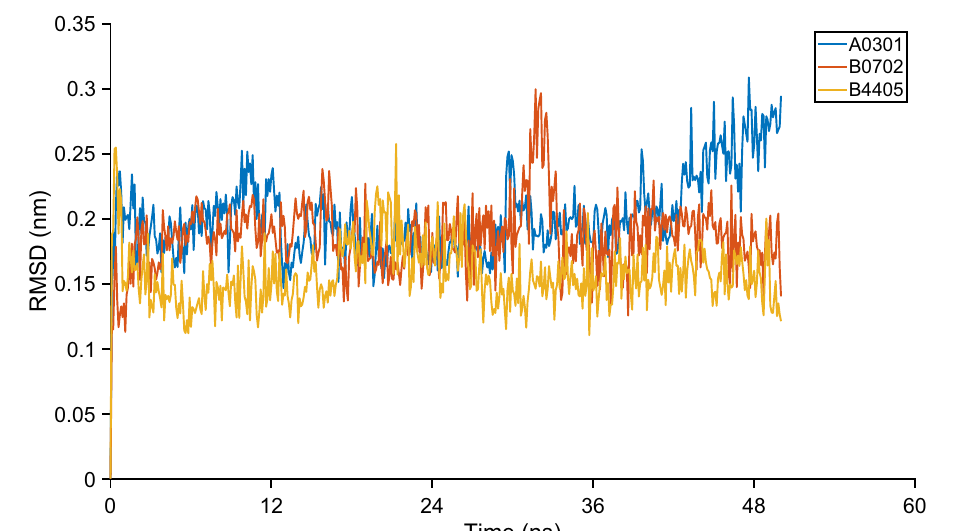
Figure 6. The RMSD plot of the HLA-epitope complex.